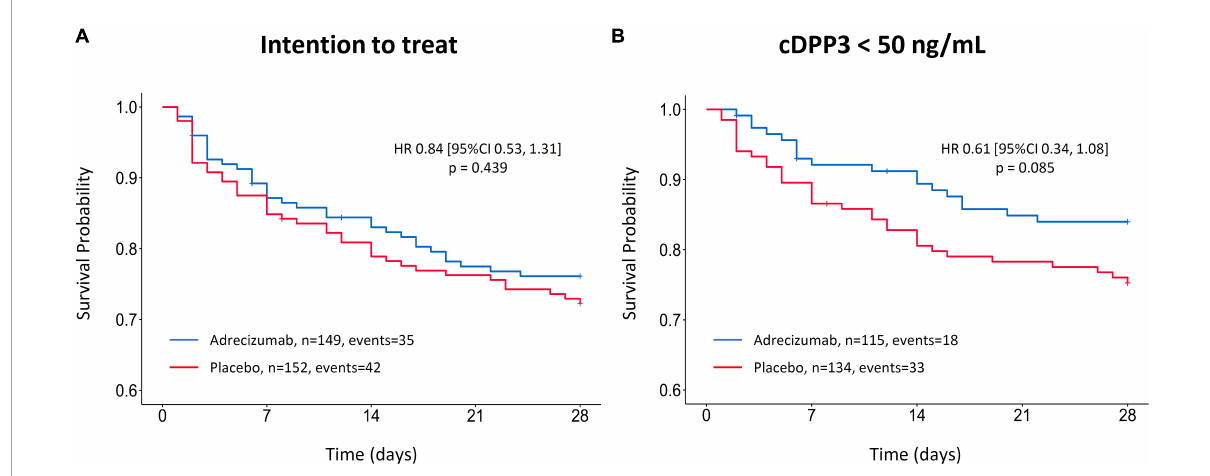
FIGURE1 Kaplan–Meier of 28-day mortality after Adrecizumab/placebo infusion, based on circulating dipeptidyl peptidase 3 (cDPP3) stratification. Data is displayed for the original intention to treat (ITT) analysis (15) (A) and the cDPP3 < 50 ng/mL subgroup (B) . Both Adrecizumab dosing groups were combined. Crosses represent censored